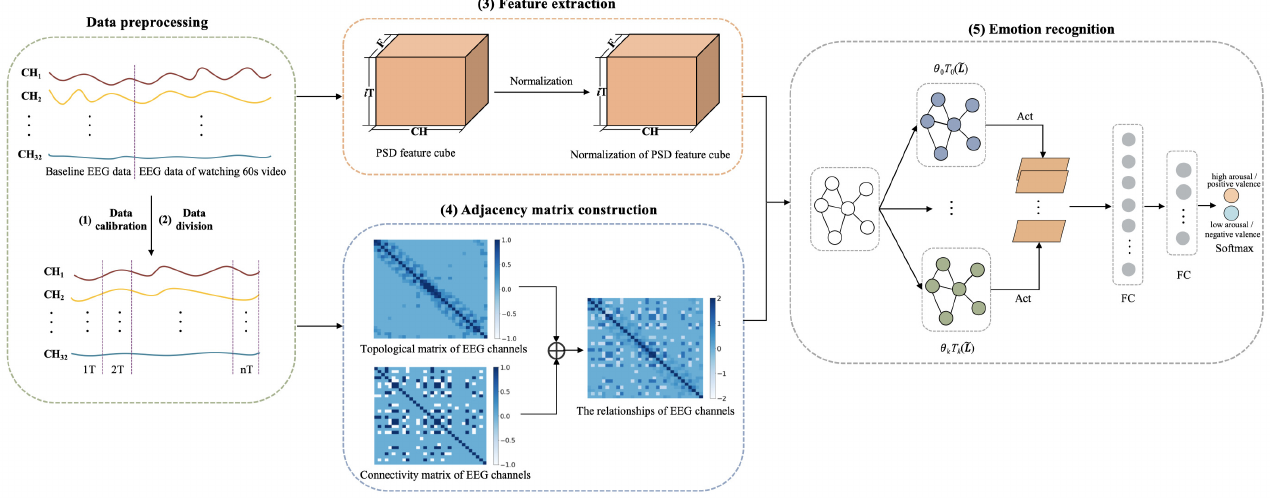
Figure 1. Framework of CR-GCN. Act denotes ReLU activation. FC denotes full connection. (1) Data calibration. First, 3 s of baseline EEG data of the subjects collected before watching the video is averaged and then replicated 20 times to form the 60 s data. Then, the corresponding baseline data is subtracted from the EEG data of watching 60 s video.